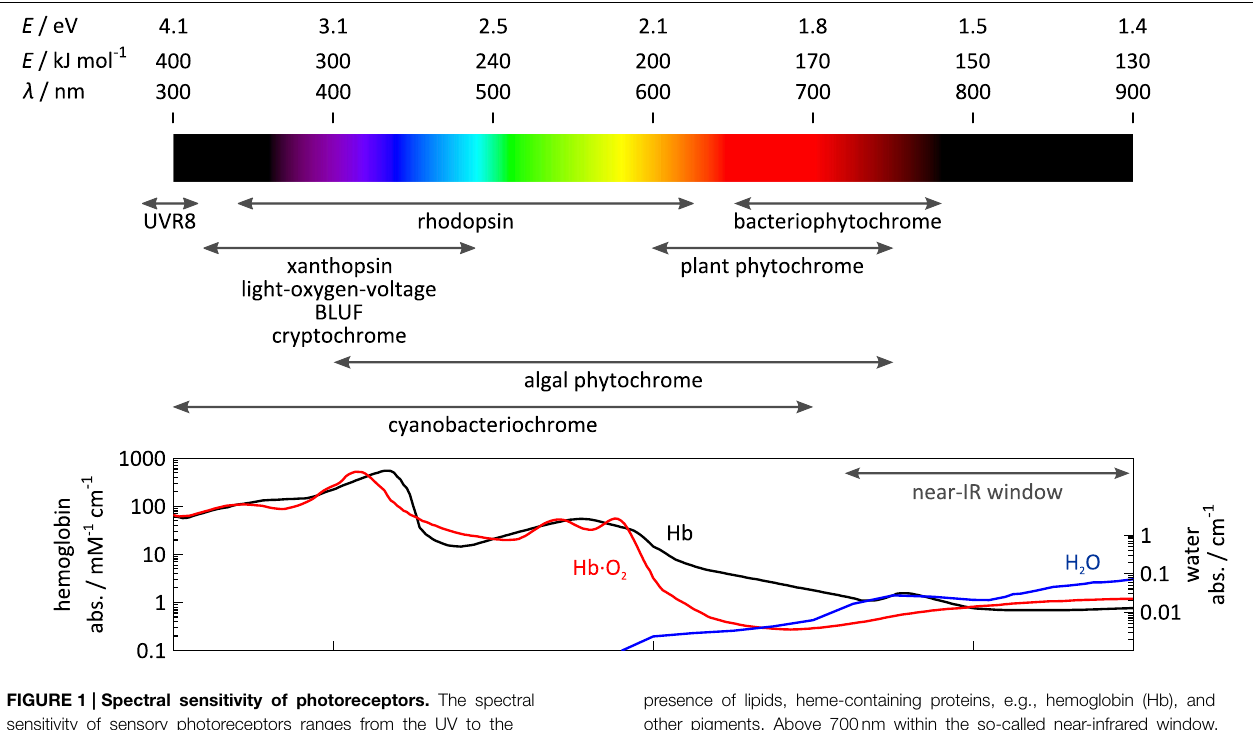
presence of lipids, heme-containing proteins, e.g., hemoglobin (Hb), and other pigments. Above 700nm within the so-called near-infrared window, scattering and absorption by pigments are lower, and light penetrates biological tissue more